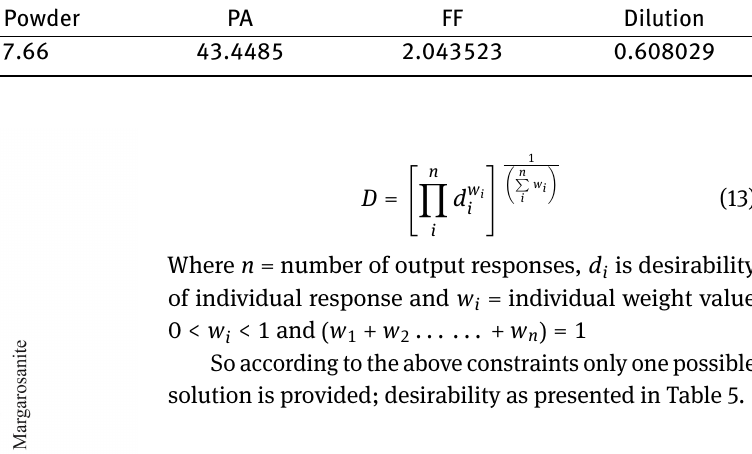
Table 5: Optimum composition of recycled slag-flux mixture for optimum bead characteristics Slag